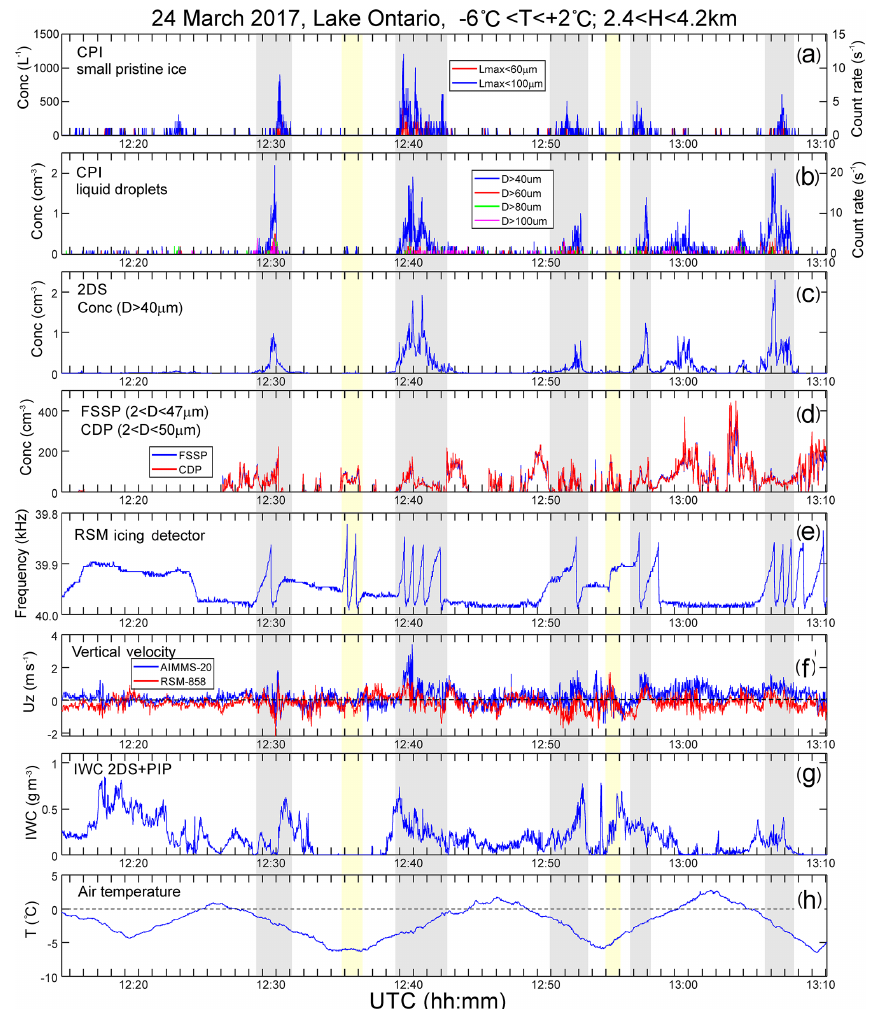
Figure 13. Time series of cloud microphysical parameters collected in a frontal cloud system over upstate New York on 24 March 2017. (a) CPI count rate of small pristine ice with L max < 60 and 100µm; (b) CPI count rate of cloud droplets with D > 40, 60, 80, and 100µm; (c) concentration of cloud particles D > 40µm measured by 2DS; (d) concentration of cloud droplets measured by FSSP and CDP; (e) Rose- mount icing detector frequency; (f) vertical velocity measured by AIMMS20 and Rosemount 858 probes; (g) IWC calculated from composite 2DS and PIP PSDs; (h) air temperature. Grey strips indicate cloud regions with enhanced concentration of small faceted ice particles; red and yellow strips indicate regions where ice and liquid were present, but no SIP was observed (see